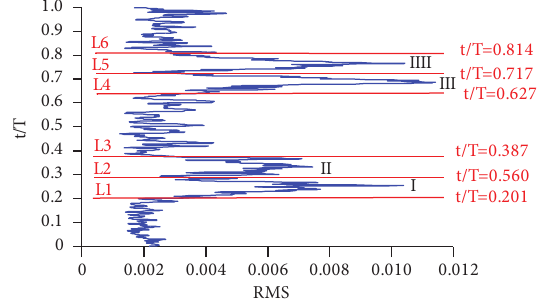
Figure 18. RMS variations in a complete cycle.